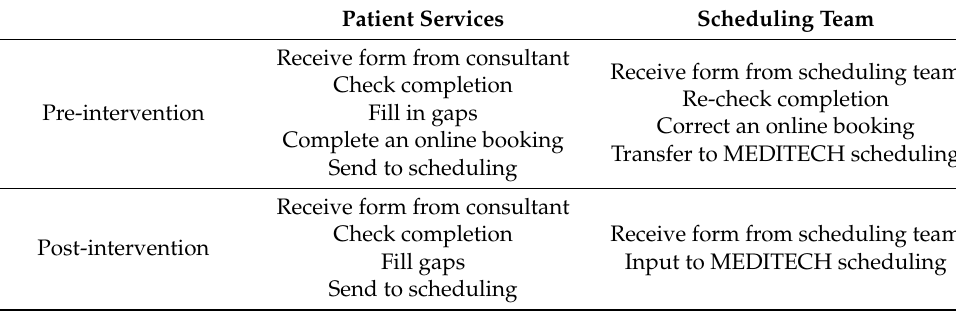
Table 6. Status pre- and post-intervention. Patient Services Scheduling